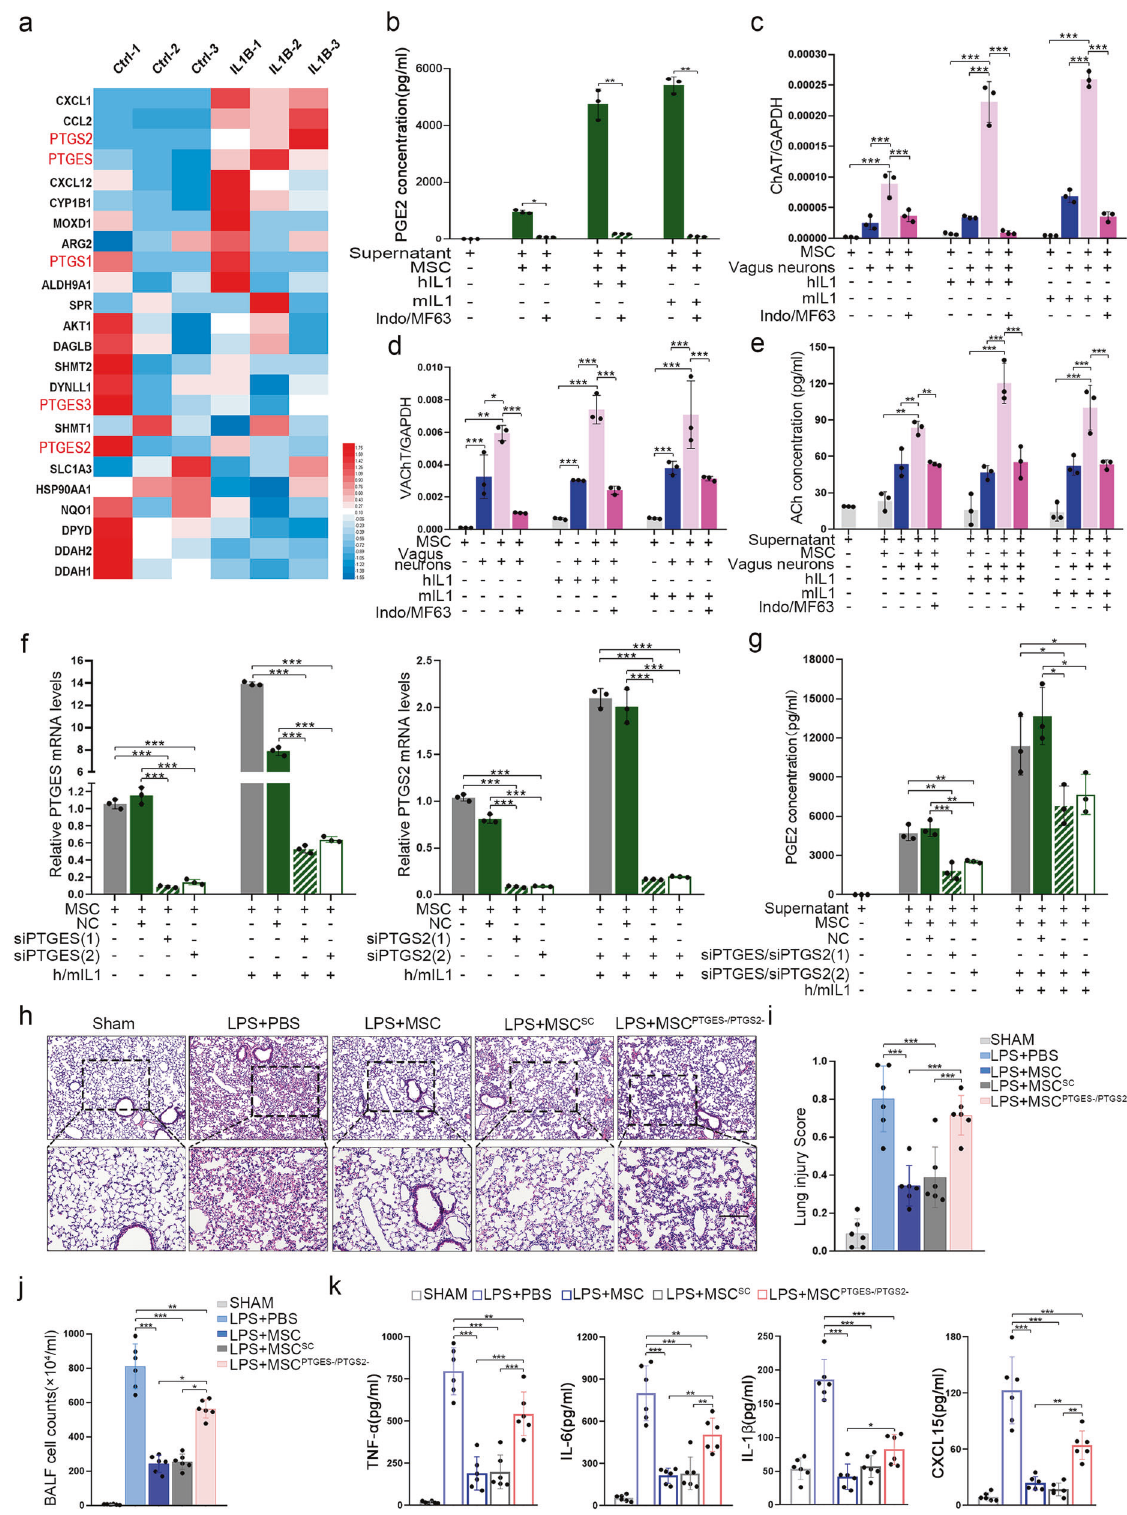
pressure were notably decreased (Fig. 6a). We observed that signi fi cant improvement of ventilation index only in the lobeline treated patients, and multiple organ assessment respiratory mechanics SOFA score was markedly decreased in lobeline group (Fig. 6a).